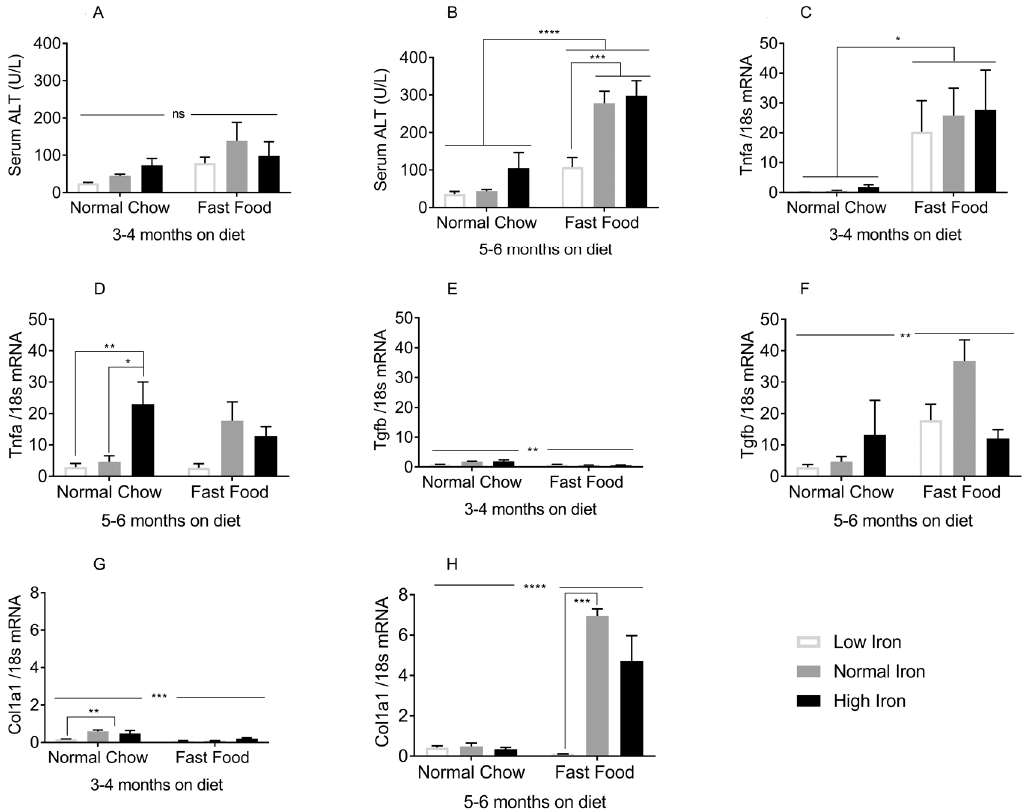
Figure 4. Effects of dietary iron and FF on NASH biomarkers: ( A , B ) Serum ALT at 3–4 and 5–6 months ( n = 3–11 per group). ( C , D ) Tumor necrosis factor alpha (Tnfa) mRNA at 3–4 and 5–6 months ( n = 3–5 per group). ( E , F ) Transforming growth factor beta (Tgfb) mRNA at 3–4 and 5–6 months ( n = 3–5 per group). ( G , H ) of collagen1alpha1 (Col1a1) mRNA at 3–4 and 5–6 months ( n = 3–5 per group). All genes were normalized to 18sRNA. Shown are means ± SE. p values were calculated with ordinary two-way ANOVA with post hoc Tukey’s multiple comparisons test. ns: not significant, i.e., p ≥ 0.05; * 0.01 ≤ p ≤ 0.05; ** 0.001 ≤ p ≤ 0.01; *** 0.0001 ≤ p ≤ 0.001; **** p < 0.0001.